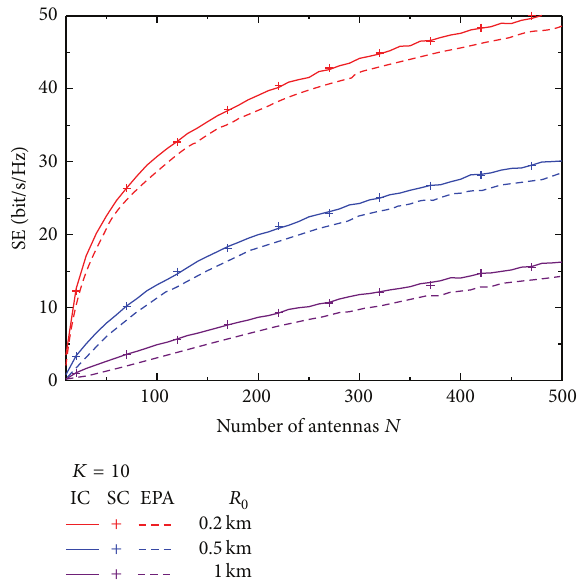
Figure 5: SE versus the number of antennas 𝑁 at the relay.